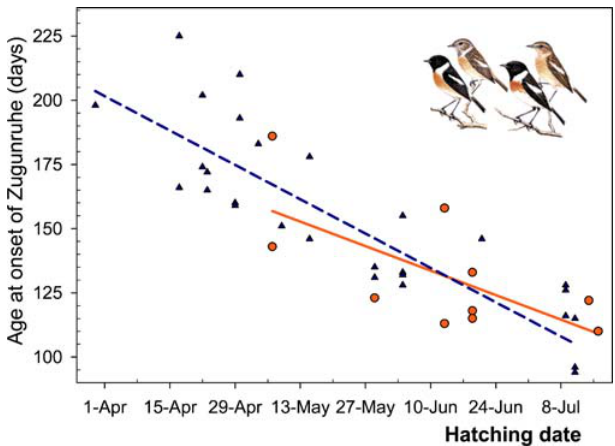
Figure 3. Relationship between Onset of Zugunruhe and Hatching Date African resident (orange dots, solid regression line; n ¼ 10) and European migrant (blue triangles, dashed regression line; n ¼ 26) stonechats initiated Zugunruhe at progressively younger ages when hatched late in the season under European day length conditions. Inlay: pairs of African (right) and European (left) stonechats; females are less conspicuously colored than males. Drawing is by H. Kacher. DOI: